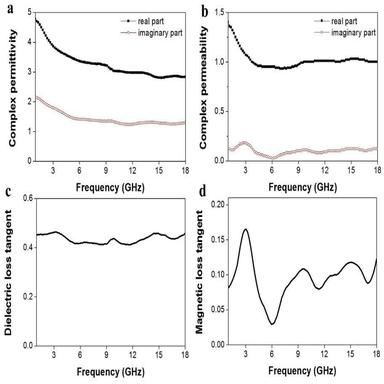
The complex permittivity (a), complex permeability (b), dielectric loss tangent (c), magnetic loss tangent (d) of the PF-NiFe2O4.